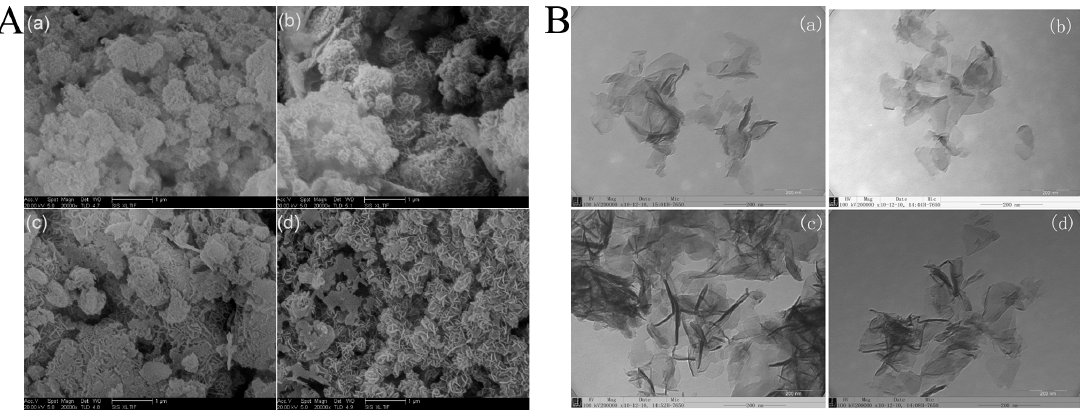
Figure 3. A : SEM (20000×) and B: TEM images (200000×) of the synthesized LDHs. ( a ) S–NiMgAl–Mn,